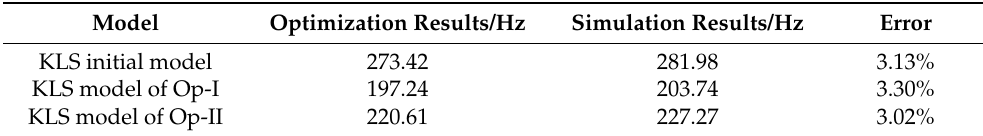
Table 10. Comparison of freq 1 between optimization results and simulation results of